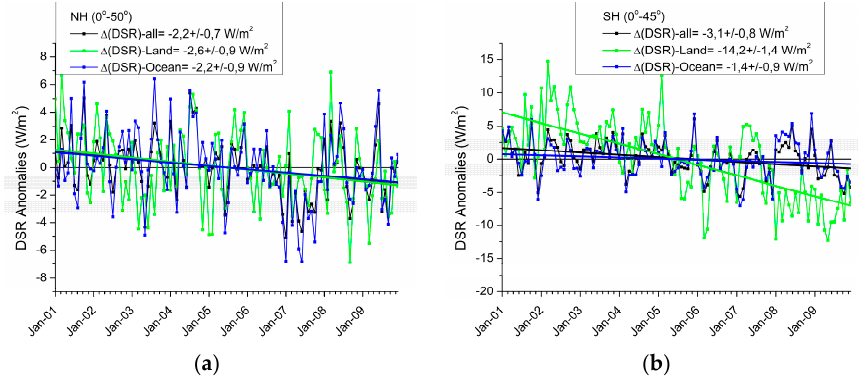
Figure 2. Time series of deseasonalized anomalies of monthly SSR fluxes averaged over land (green lines), ocean (blue lines), and land + ocean (black lines) regions of the Northern Hemisphere ( a ) and the Southern Hemisphere ( b ), over the period 2001–2009. The global dimming and brightening (GDB) magnitudes (SSR changes ( Δ SSR), in W m − 2 ) and the associated standard error values over the period 2001–2009 are also given for each hemisphere.